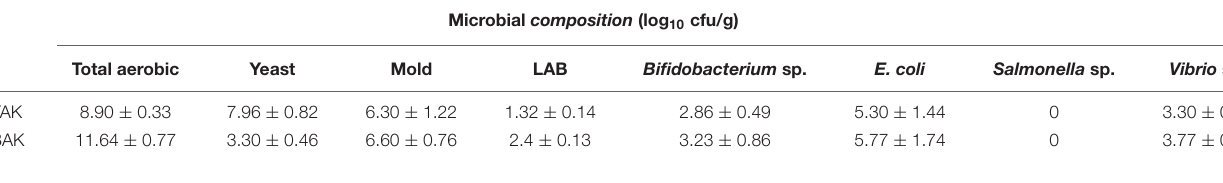
TABLE 1 | | Enumeration of different group of microbes in both YAK and BAK. Microbial composition (log 10 cfu/g) Total aerobic Yeast Mold LAB Bifidobacterium